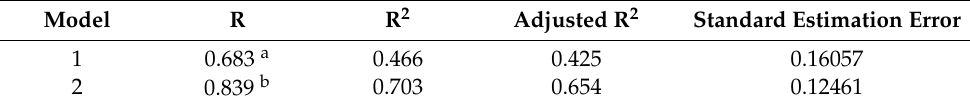
Table 5. Yield model of HCPS.